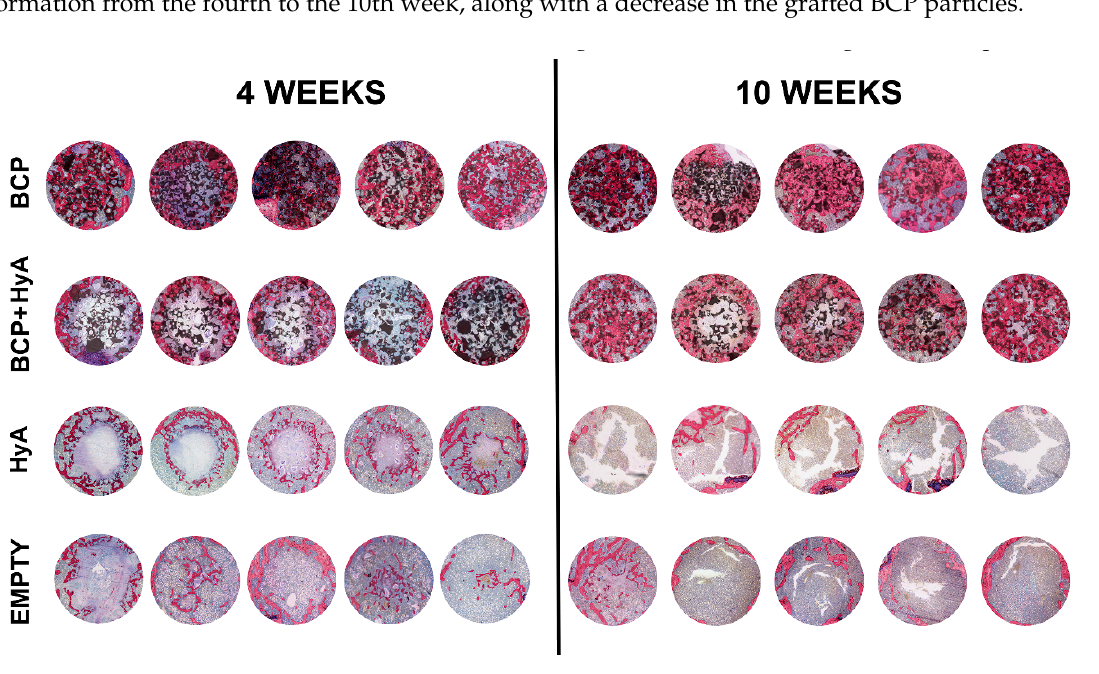
Figure 4. Representative histological images stained with methylene blue and basic fuchsin, showing non-decalcified (pMMA embedded) cross-sections of the di ff erent experimental bone defects during each time period.